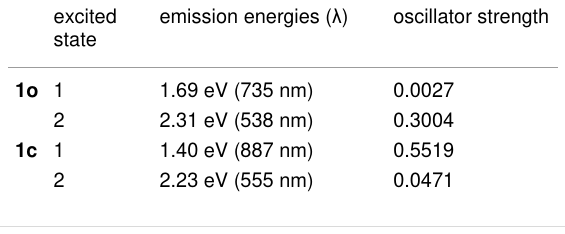
Table 4: Emission energies for 1o and 1c in